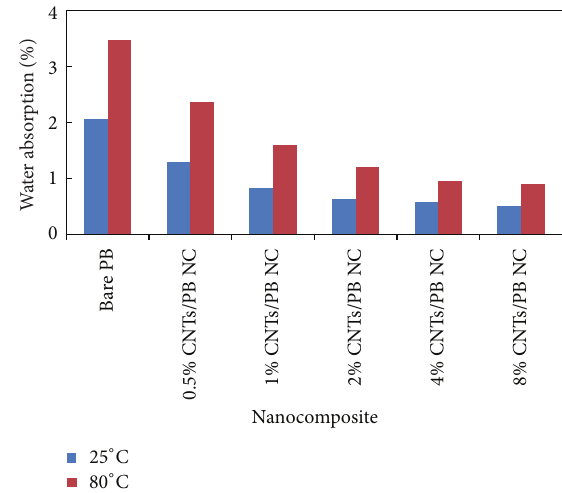
Figure8:WaterabsorptiondataofbarePBandCNTs/PBnanocom- posites determined at ambient (25 ∘ C) and elevated (80 ∘ C) tempera-